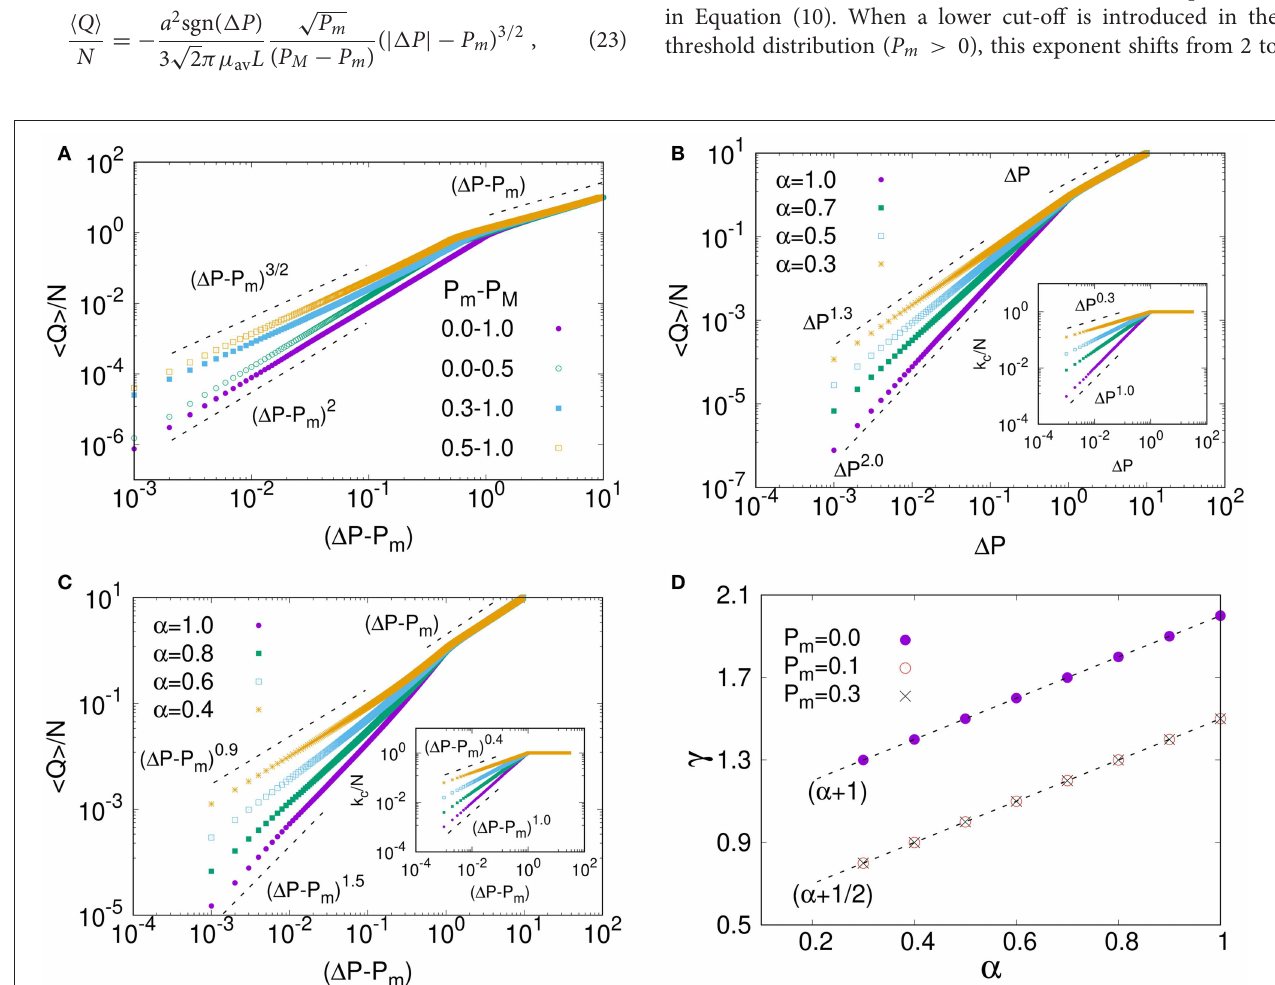
Q / N as a function of pressure 10 5 capillaries and averaged over 10 4 configurations. Variation of = h i α α 1 for P m 0 and as γ 1 / 2 for P m > 0. These two relations are shown in = + = = + P m ) α 0 and for P m > 0. Here, the number of active capillaries ( k c ) vary with 1 P as k c / N ( 1 P = ∼ −